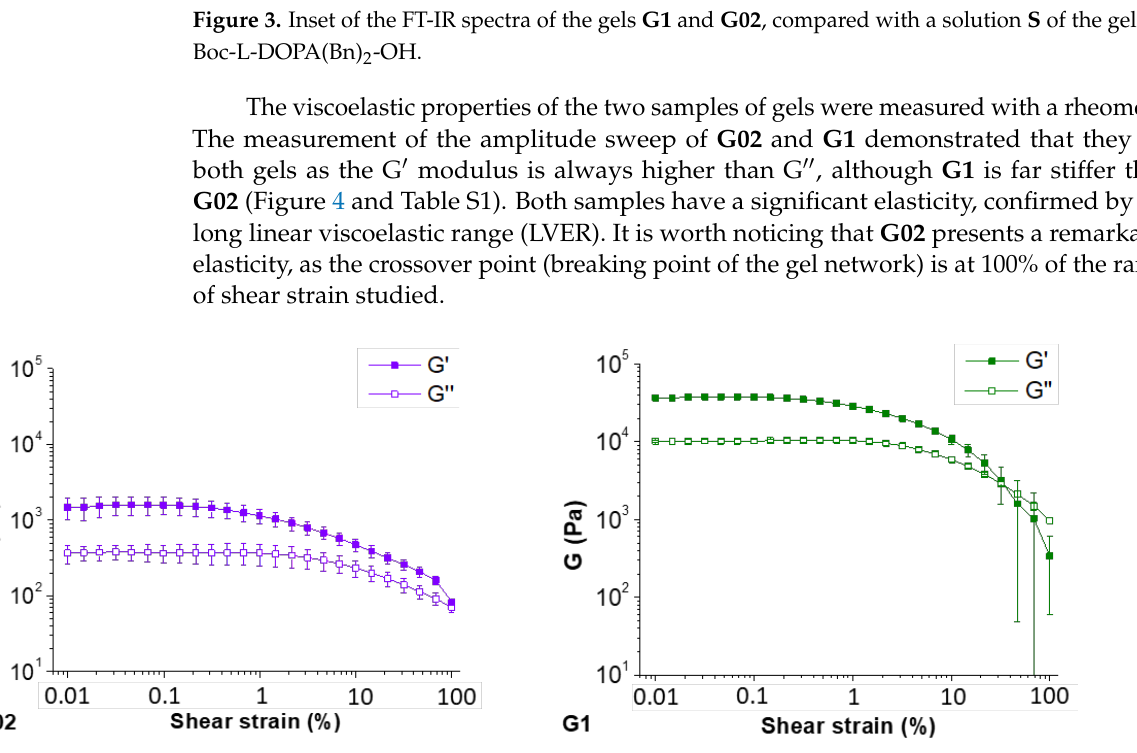
Figure 4. Amplitude sweep analyses of G02 ( left ) and G1 ( right ). The experiments were repeated in triplicate and results are expressed as mean ± standard deviation.